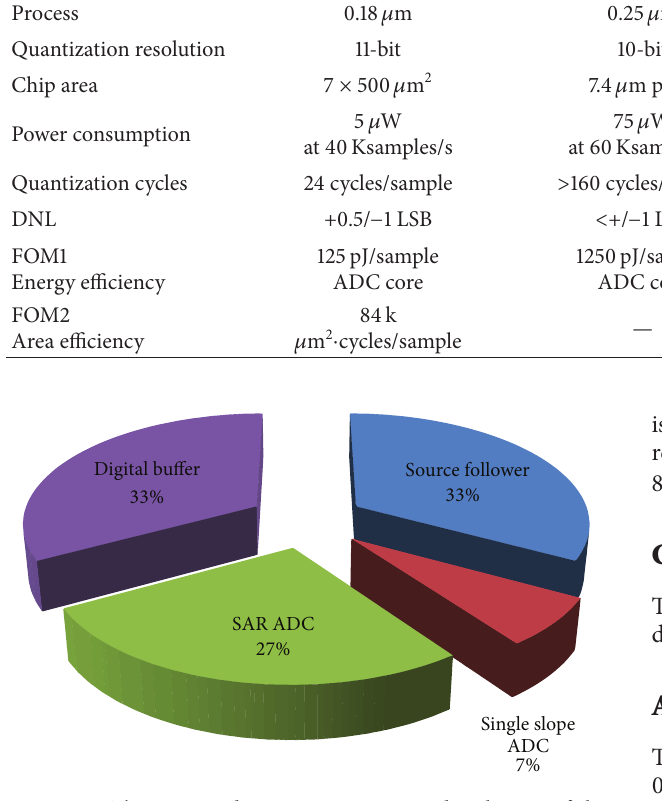
Figure 12: The measured power consumption distribution of the column-parallel